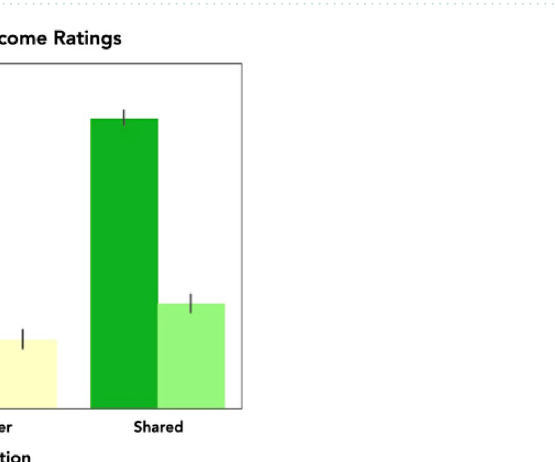
Figure 1. Experimental design and task schematic. ( a ) Participants (decision-makers) were recruited into one of two groups. Decision-makers in the Stranger group (N = 29) were introduced to a sex-matched confederate, while decision-makers in the Friend group (N = 28) were asked to bring a same-sex close friend. Participants were told that the other person (the stranger or their friend) would be taking part in the study with them at different points. At the beginning of the experimental session, decision-makers in both groups completed a series of self-report measures. Following completion of these measures, the experimental task began in which participants chose between risky (50%/50%) monetary gambles or guaranteed monetary outcomes ( b ). Decision-makers in both groups made these choices first in a baseline ‘self’ condition (i.e., outcomes of choices affected only themselves), and then made two other sets of identical choices in a ‘shared’ condition (i.e., outcomes of choices were shared between themselves and another person) and an ‘other’ condition (i.e., outcomes of choices were for another person). The order of these social conditions was counterbalanced across participants in both groups.